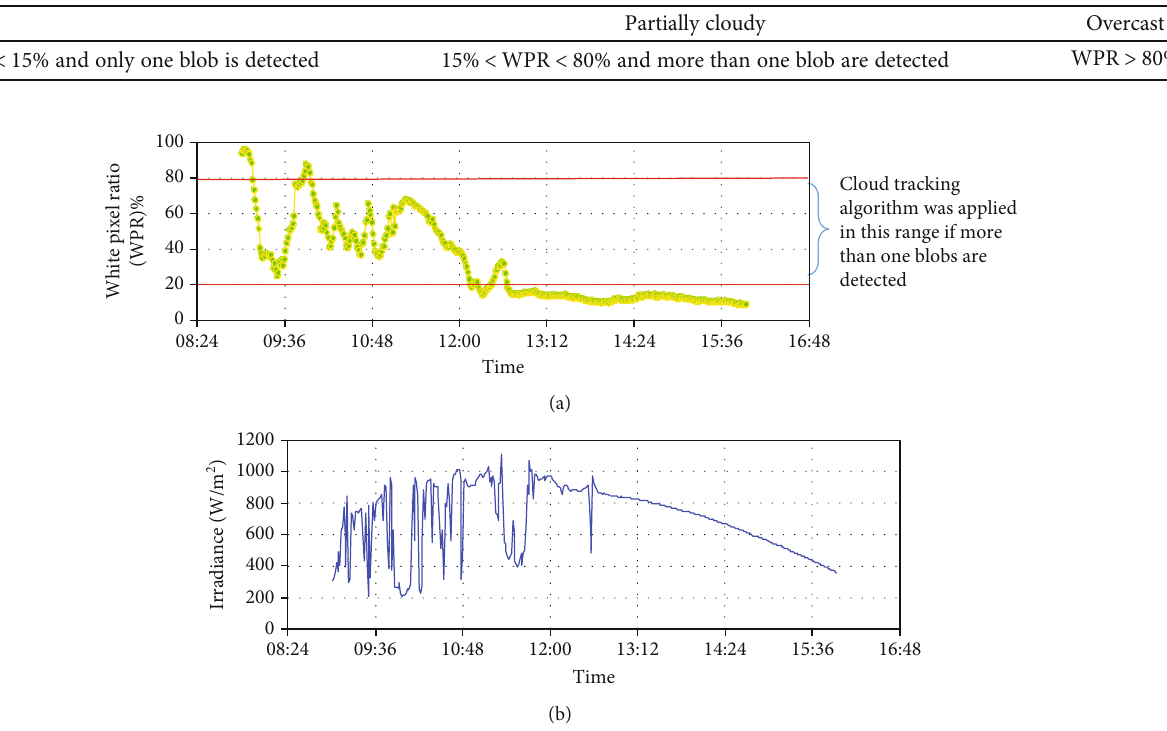
Figure 10: (a) White pixel percentage of the fi rst image in each image set captured on 2018/09/20 and (b) measured (i) The point (in the last image of the image set) that creates a shadow on the PV plant was found (point “ P ” shown in Figure 5) (ii) A number of points inside each white blob of the last image frame were selected in such a way that the dis-